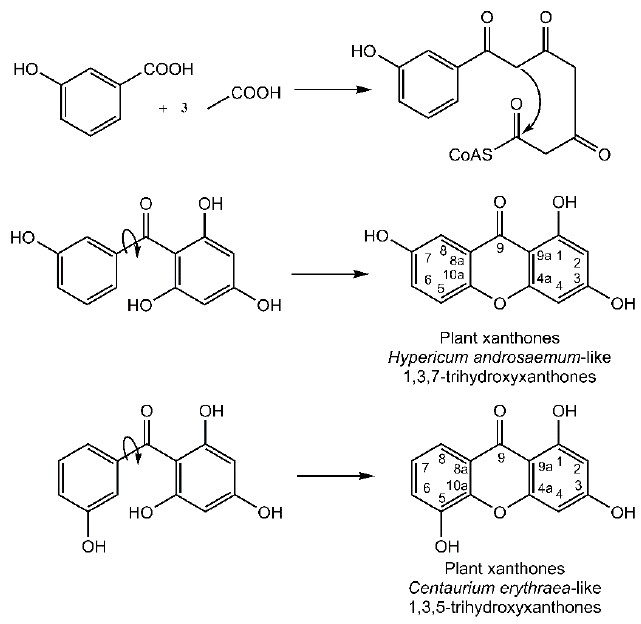
Figure 3. Biosynthesis of xanthones within plants .